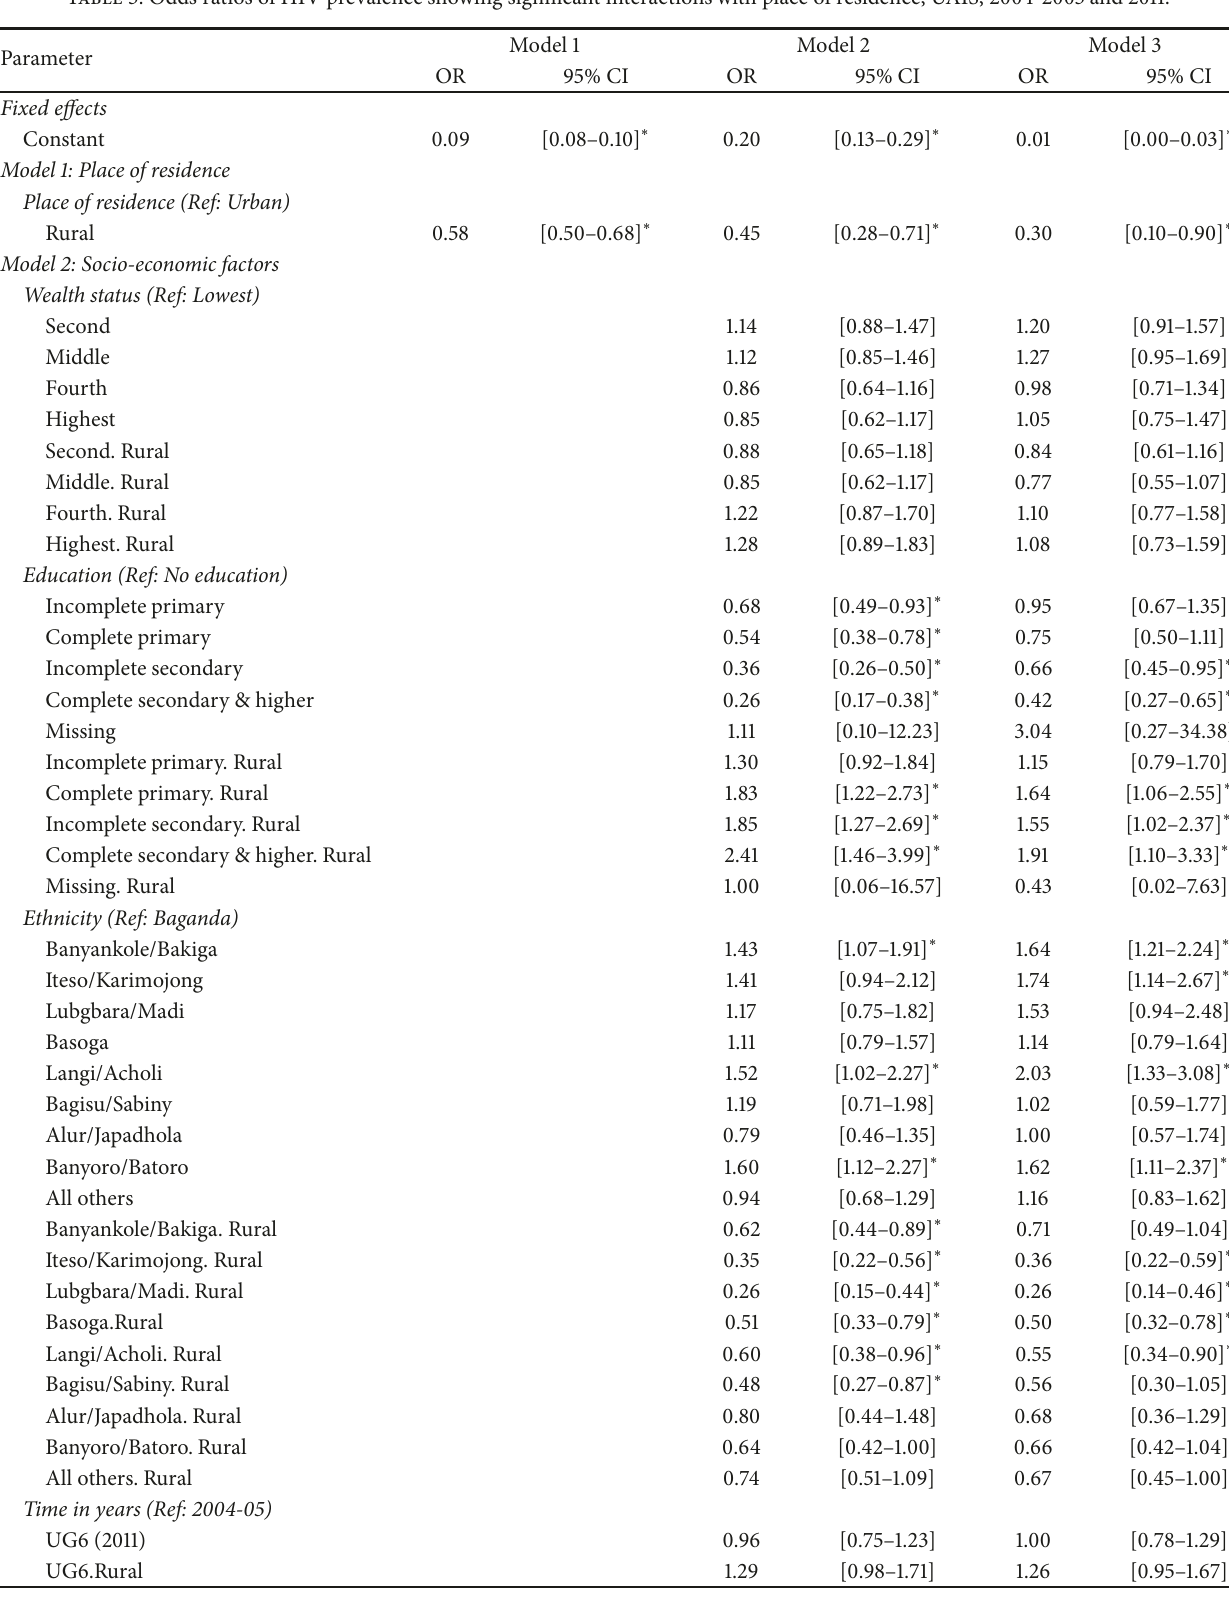
Table 5: Odds ratios of HIV prevalence showing significant interactions with place of residence, UAIS, 2004-2005 and